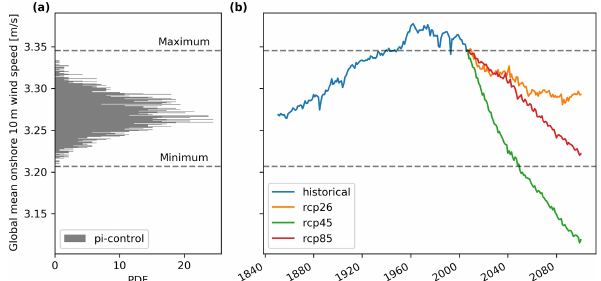
Figure 5. Global mean onshore wind speeds in MPI-GE. (a) His- togram of pre-industrial control annual mean wind speeds (flipped). (b) Ensemble-mean wind speed evolution during historical (blue) and rcp (red, orange, green)